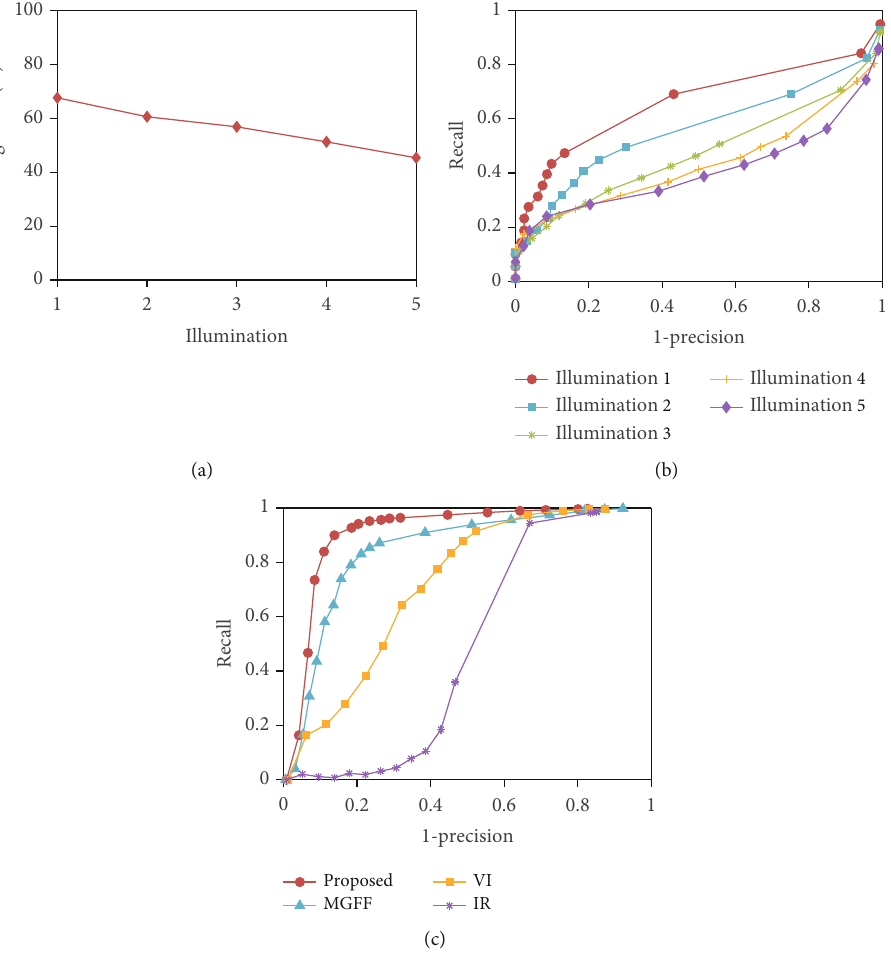
Figure 15: Robustness in di ff erent imaging